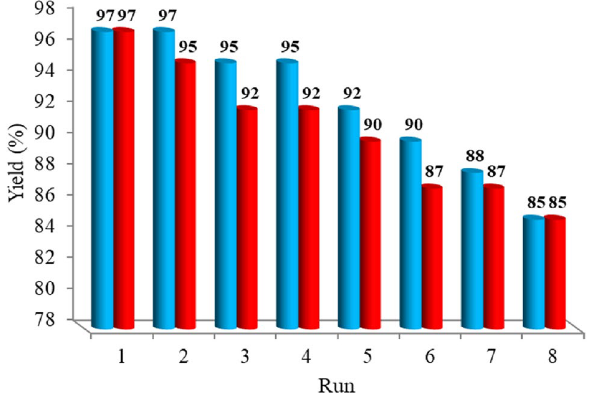
Figure 15. Recycling chart of Fe 3 O 4 @SiO 2 -Im[Br]-SB-Cu (II) MNP catalyst for the synthesis of 1-aryl 1 H -tetrazole (blue) and 5-aryl 1 H -tetrazole (red) derivatives.